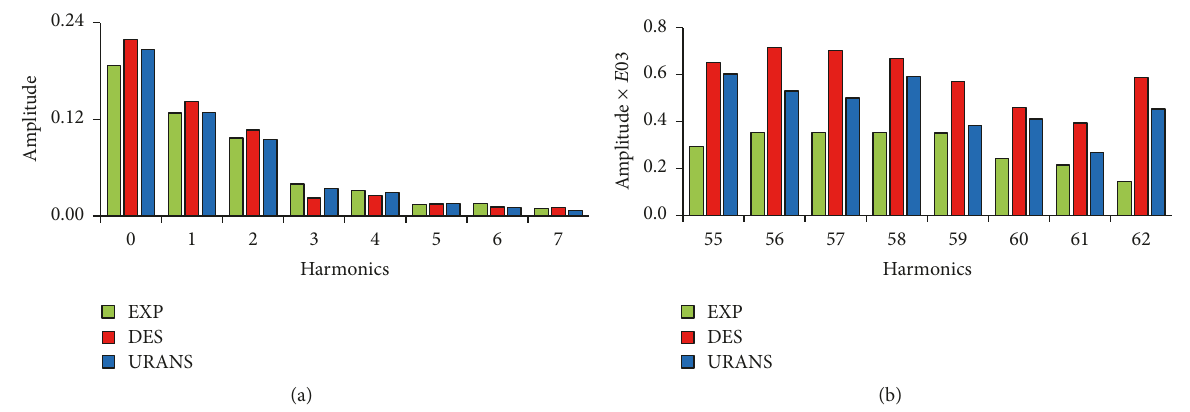
Figure 14: Harmonic results of ship’s wake: (a) low harmonics and (b) high